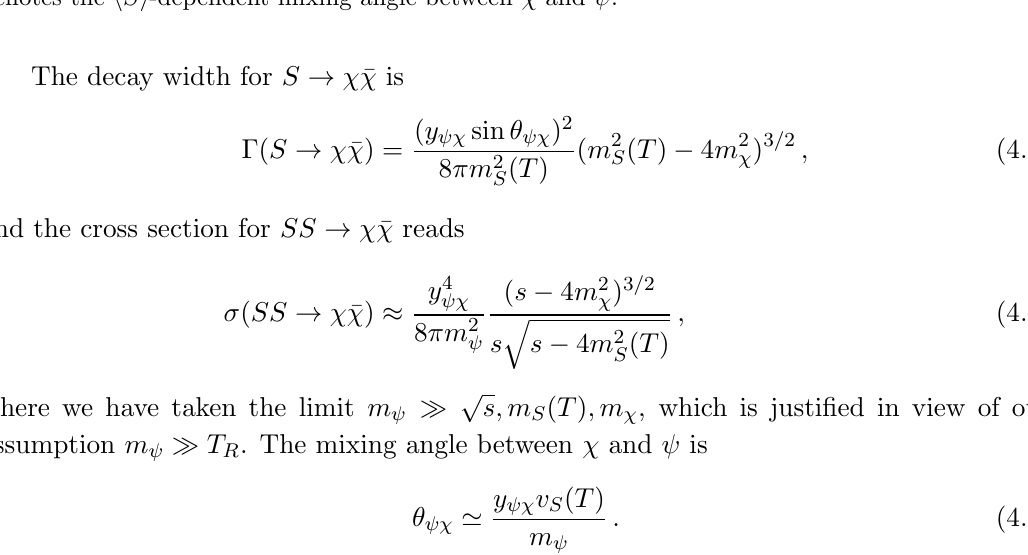
Figure 9 . Feynman diagrams contributing to DM freeze-in in the mixing induced scenario. (cid:18) denotes the h S i -dependent mixing angle between (cid:31) and